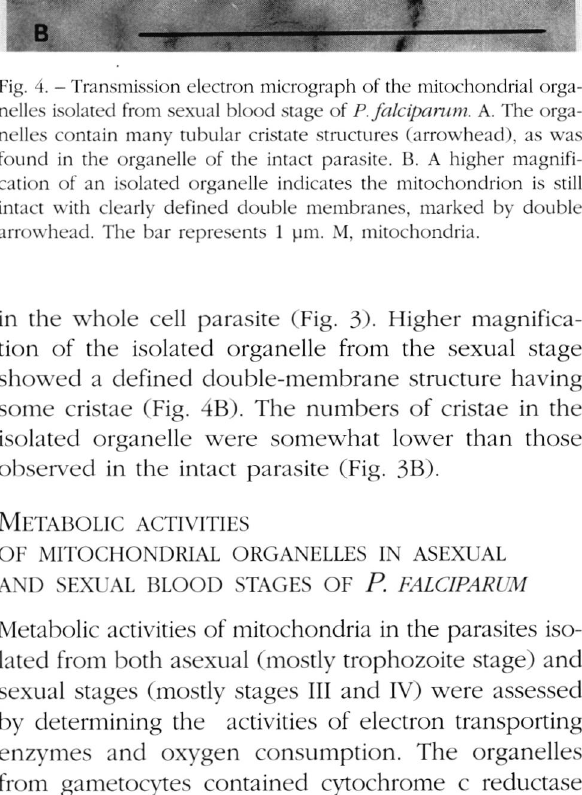
pectively. For comparison, the two enzymes in the organelles isolated from the asexual trophozoite stage were found to be 2.2 ± 0.3 (n = 6) for cytochrome c reductase and 2.8 ± 0.6 (n = 6) for cytochrome c oxi dase. The rate of oxygen consumption by isolated mitochondrial organelles was determined (Table II). It was found that the rate of oxygen consumption by both asexual and gametocytic stages was relatively low, comparing to the mammalian mitochondria. Never theless, their oxygen consumption were shown to be different, with the calculated values of 1.66 ±